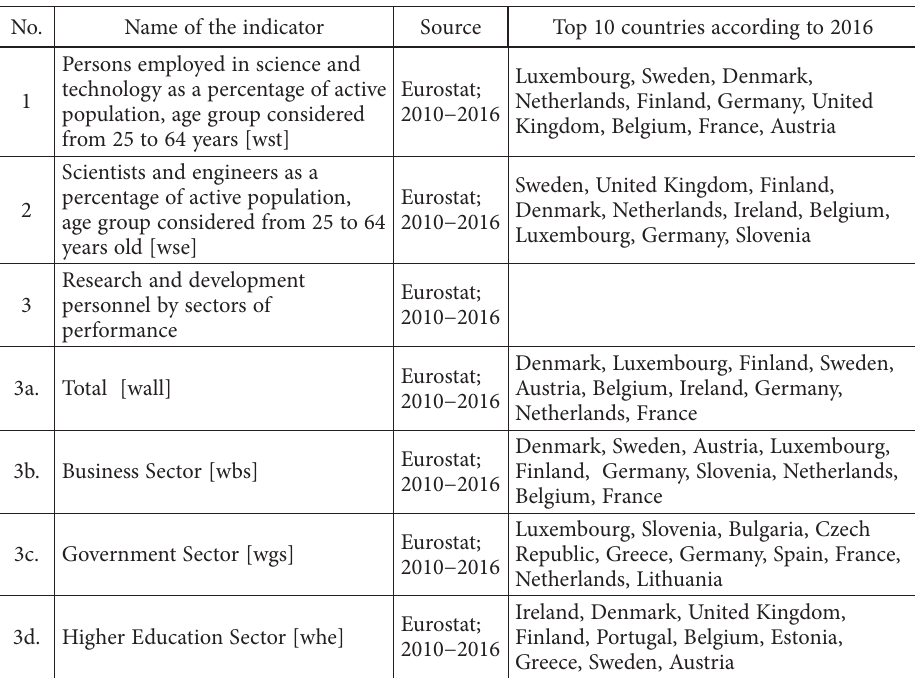
Table 3. Indicators serving as weights in the index measuring the average level of innovativeness (source: own elaboration based on the data of the European Statistical Office – Eurostat) No. Name of the indicator Source Top 10 countries according to